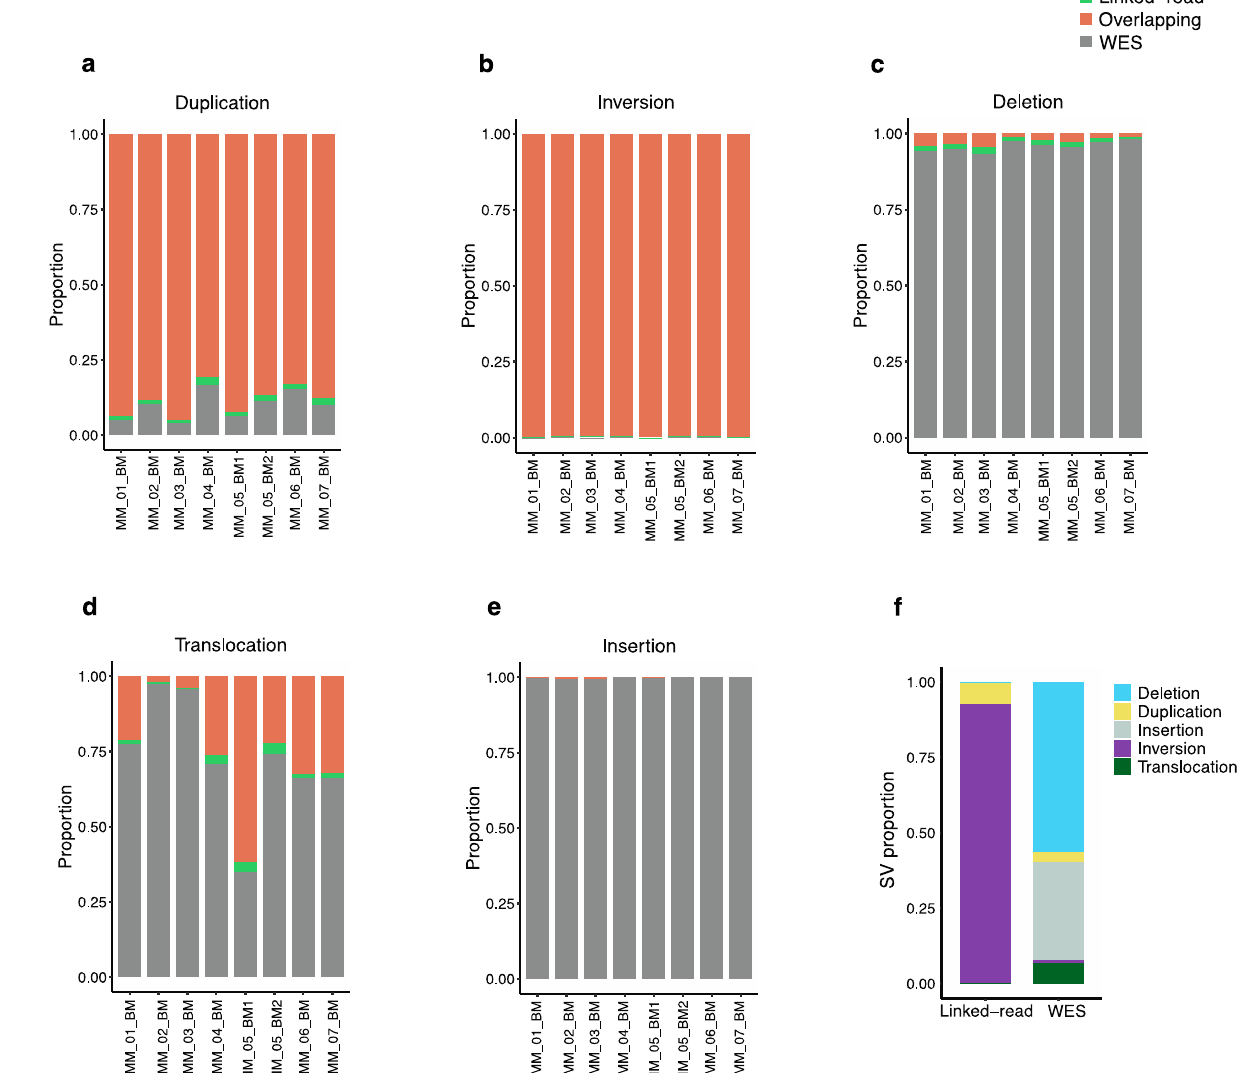
Figure 3. Total structural variants detected by linked-read sequencing and WES. The proportion of each type of structural variation separately across all 8 tumor samples. The orange bar represents the proportion of linked-read, the gray bar represents that of WES, and the green bar represents overlaps ( a ) Duplication; linked-read sequencing detected a higher proportion of duplication ( b ) Inversion; linked-read detected more than 99% of inversions called in each sample. ( c ) Deletions; WES detected more deletions across all the samples. ( d ) Translocations; with the exception of one sample, WES detected a higher proportion of translocations across the samples. ( e ) Insertions; WES detected 99.86% of all insertions. ( f ) The proportion of each type of SV is called by each sequencing method. Linked-read sequencing detected more duplications and inversions. No insertions were observed in the linked-read data as the insertion calls represent only 0.009% of total linked-read calls.